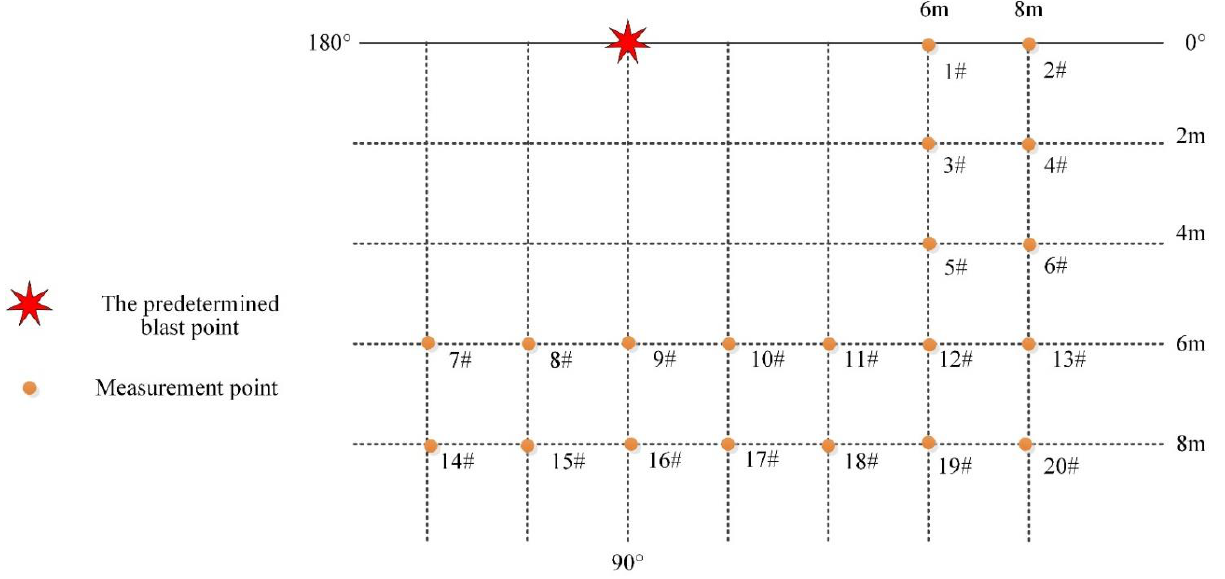
Figure 2. Schematic of the measurement points in the moving charge explosion experiment.